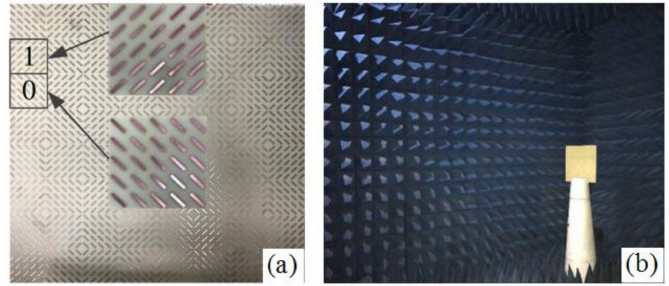
Figure 8. ( a ) The fabricated 01/10 coding MS sample; ( b ) the measurement setup in the microwave anechoic chamber.